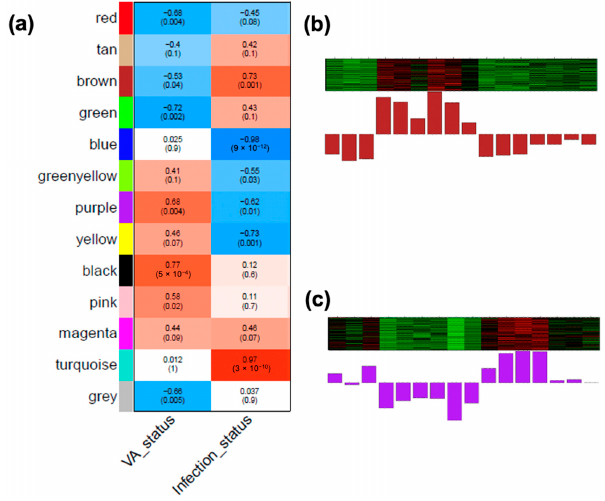
Figure 6. Correlation of modules with VA and the infection status in the colon. ( a ) Correlation of biological traits with colonic module eigengenes, calculated by the WGCNA. Upper numbers in each cell: correlation coefficient between the trait (VA and the infection status) and the module eigengene. Lower numbers in parentheses: p -value of the corresponding correlation. Significant cor- relation with the infection status were obtained on the Colon(Blue), Colon(Turquoise), Colon(Brown), Colon(Yellow), Colon(Purple), and Colon(Green–yellow) modules, among which Colon(Brown) and Colon(Purple) were significantly correlated additionally with the VA status. The eigengene values (Y-axis) of Colon(Brown) and Colon(Purple) across samples (X-axis) are visualized in ( b , c ). Abbreviations : vitamin A (VA), weighted gene co-expression network analysis